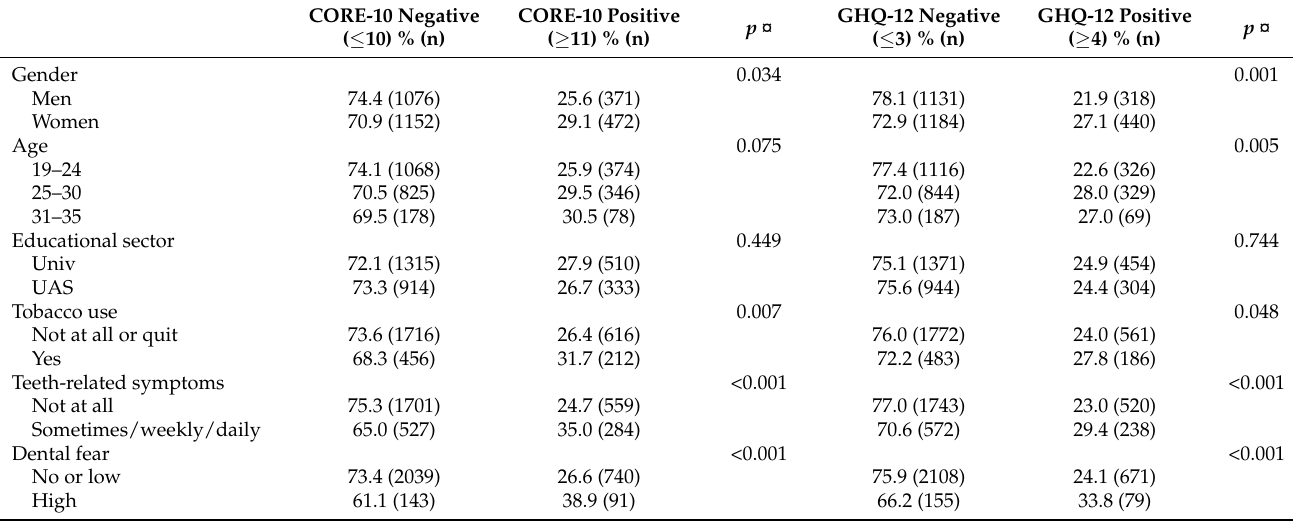
Table 3. Gender, age, educational sector, dental fear, teeth-related symptoms and tobacco use by CORE-10 and GHQ-12 ( n = 3073) among the Finnish university